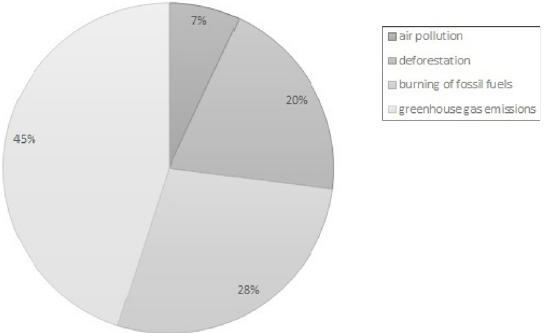
Figure 2. Cased of